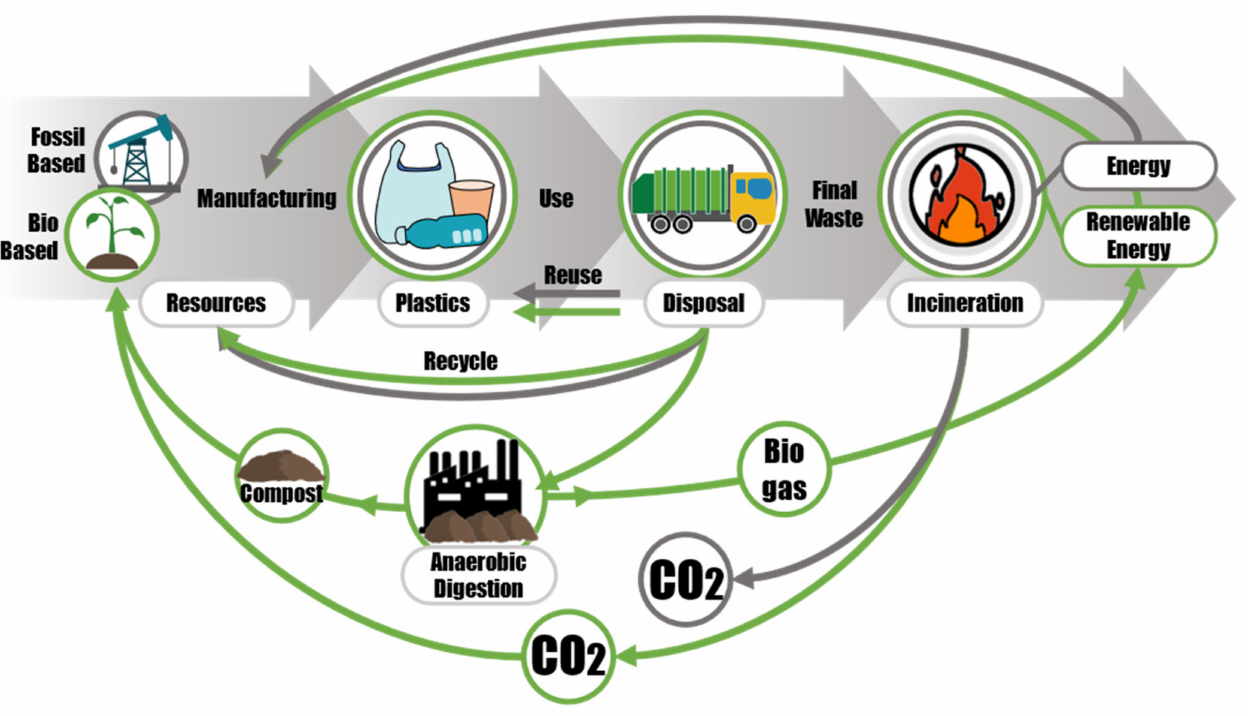
Figure 2. A simplified infographic representing the main steps in linear economy (straight arrows) and the additional steps introduced by circular economy with a focus on bioplastics (green arrows), considering anaerobic digestion as EOL option for compostable plastics, reuse and recycling for durable bio-based plastics and incineration as final disposal of any plastic that is no longer recyclable nor